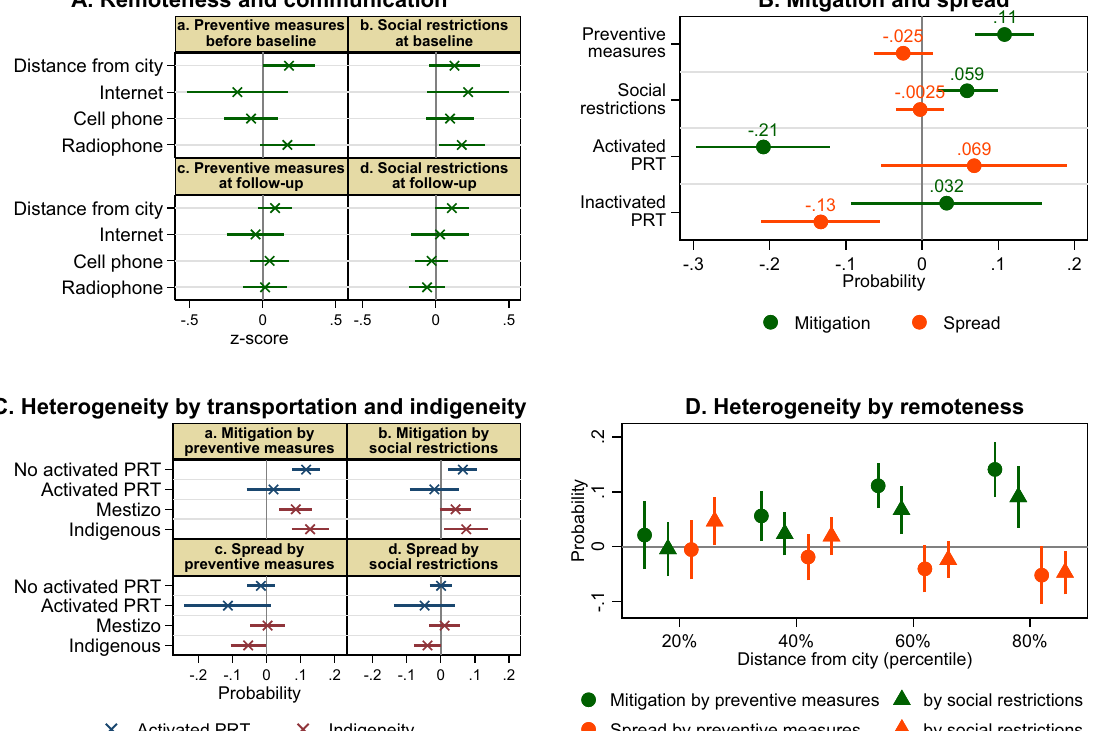
Figure 4. Social behaviors and transportation restrictions. The estimated predictors of self-protective behaviors (z-score) ( A ), the estimated impacts of a change in self-protective behaviors (z-score) and public river transportation (PRT) (0/1) on COVID-19 mitigation and spread between the baseline and follow-up surveys (0/1) ( B ), heterogenous impacts by PRT and indigeneity ( C ), and heterogenous impacts by distance from city (percentile) ( D ), with 95% confidence intervals based on robust standard